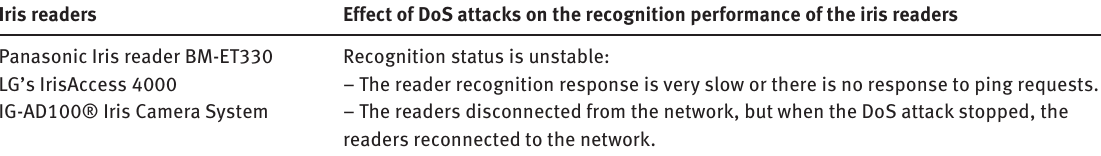
Table 2. DoS Attacks Results for Iris